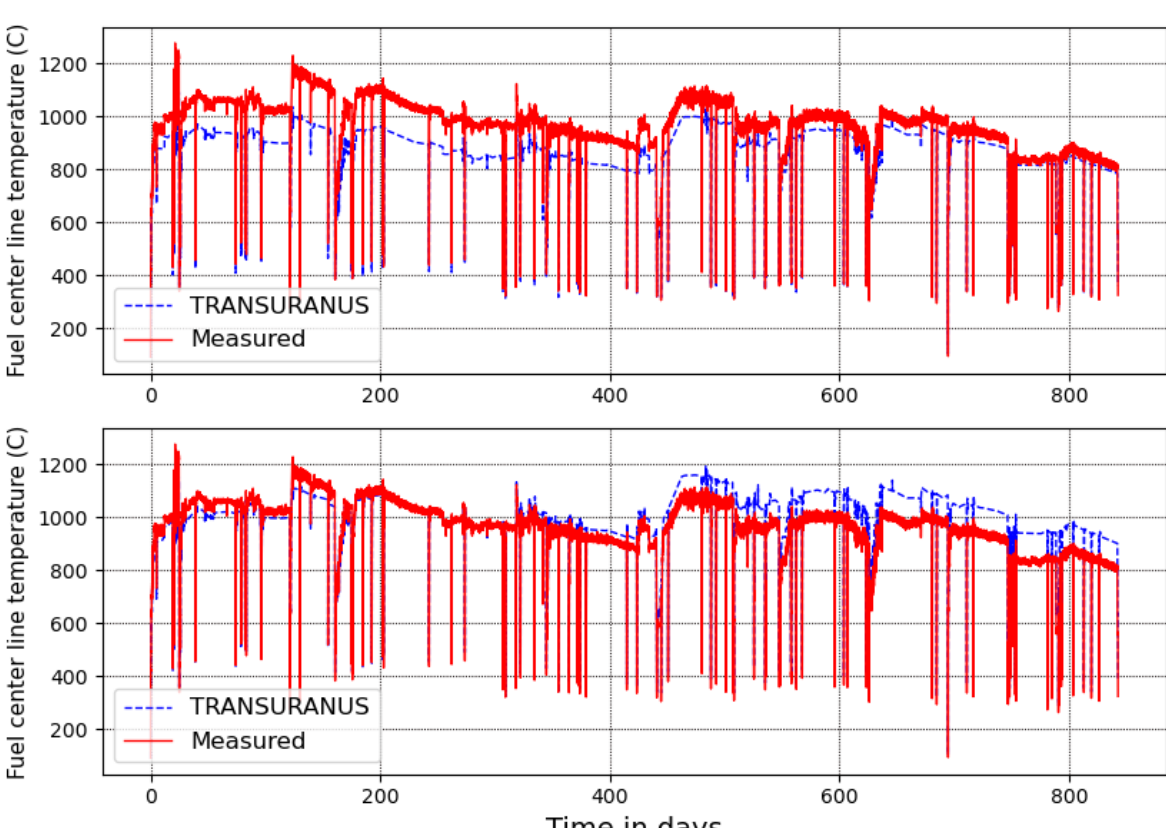
Figure 8. Fuel center line temperature measured by thermocouples during the IFA 716 test compared to simulated FCLT using standard thermal conductivity correlation (top) by Hading et al. [12] and high burnup thermal conductivity correlation by Ohira et al.